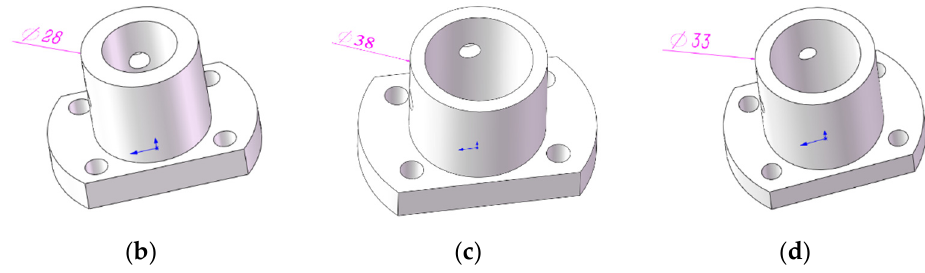
Figure 9. Some actual 3D parts( a – j represent different parts).